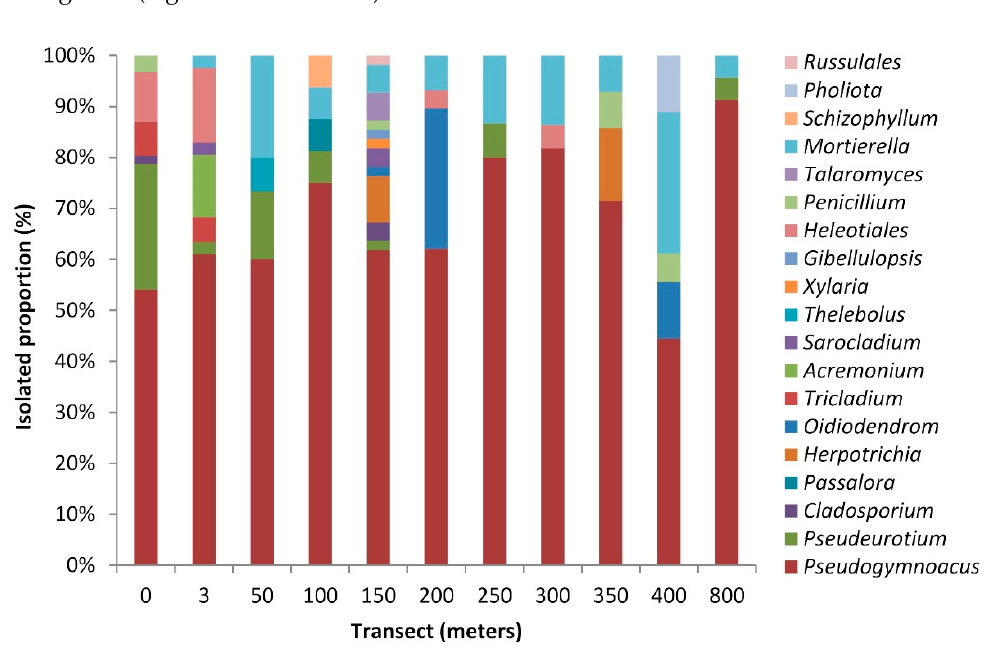
Table 1. Indices and richness estimator ( α -diversity) for the correlated sampled points in meters from the retreating Collins Glacier.